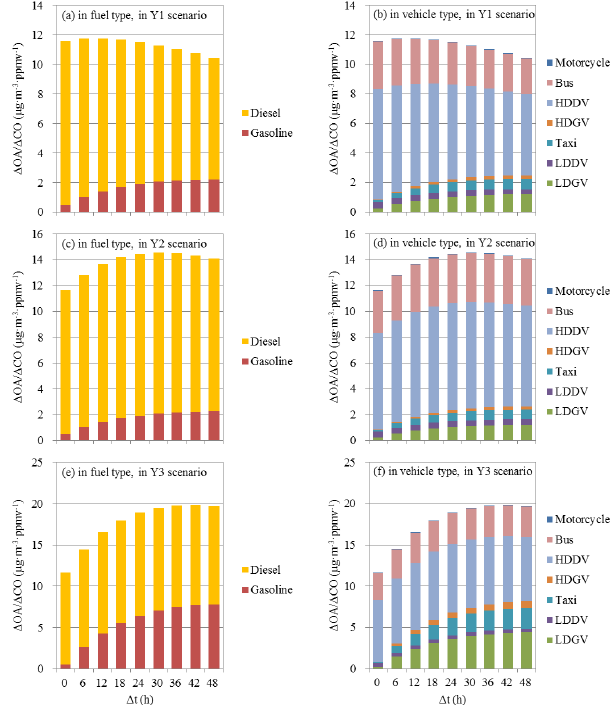
Figure 8. Contributions of vehicle emissions to OA formation ratios in different vehicle and fuel types in Y1, Y2 and Y3 scenarios with the changes of photochemical